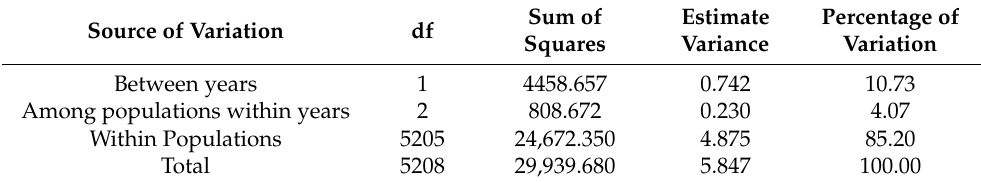
Table 7. Analysis of molecular variance (AMOVA) for Plasmopara viticola populations in open-field, fungicide-managed, and rain shelter cultivations during the period 2016–2017. Sum of Estimate Percentage of Source of Variation df Squares Variance Variation Between years 1 4458.657 0.742 10.73 Among populations within years 2 808.672 0.230 4.07 Within Populations 5205 24,672.350 4.875 85.20 Total 5208 29,939.680